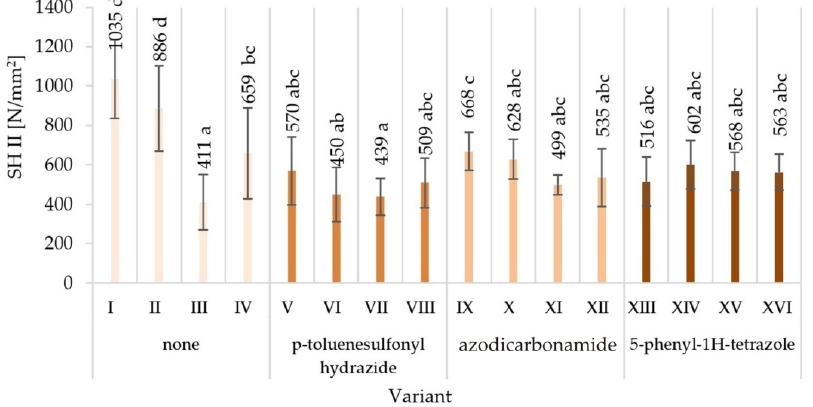
Figure 5. Internal bond strength (IB) of particleboards produced (means and standard deviation, a, b, c, …—homogeneous groups determined by the Tukey test; different letters denote a significant difference; means followed by the same letter do not statistically differ from each other).